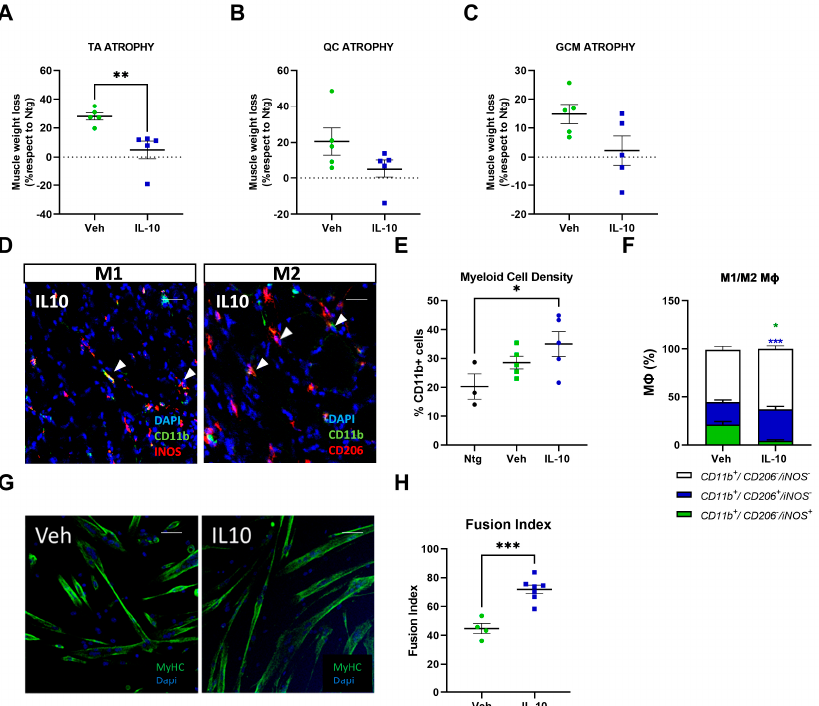
Figure 7. Intramuscular IL-10 administration preserves skeletal muscle in transgenic